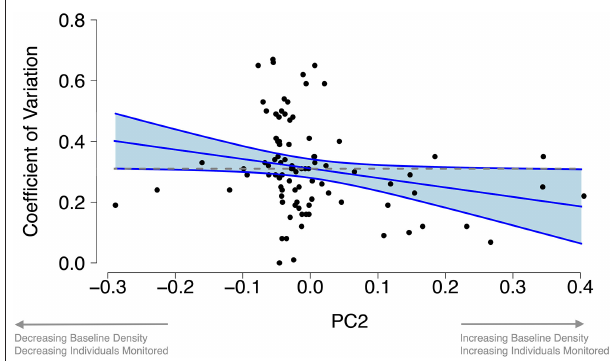
FIGURE 2 | Study design characteristics predicting increases in density precision. Density precision increased with increasing values of PC2 (describing axes of increasing density and increasing individuals monitored). Data points are species-specific values of the Coefficient of Variation. Larger values mean lower precision. Blue line and shaded area represent the slope and 95% Confidence Intervals from our linear model. Dashed gray line represents the mean Coefficient of Variation in our